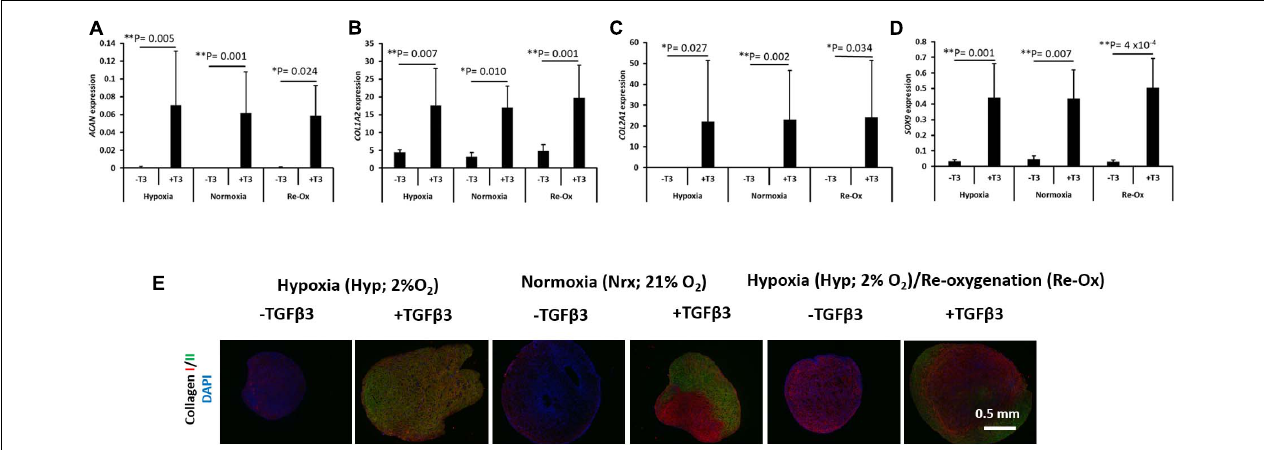
FIGURE 4 | Chondrogenic gene expression and immunofluorescence of types I and II collagen. Relative mRNA expression of (A) aggrecan ( ACAN ), (B) type I collagen ( COL1A2 ), (C) type II collagen ( COL2A1 ), and (D) SRY-Box transcription factor 9 ( SOX9 ) for seven donors with independent duplicates ( N = 7, n = 14 per experimental group). Gene expression was normalized to the geometric mean of three housekeeping genes ( YWHAZ , β -actin , and B2M ). Bar data are mean ± standard deviation. Statistical comparisons were based on Kruskal–Wallis test between without TGF β 3 (i.e., –T3) and with TGF β 3 (i.e., +T3) groups within an oxygen tension group. ∗ p -value < 0.05; ∗∗ p -value < 0.01. (E) Immunofluorescence (IF) for collagens I and II and DAPI for cell nuclei. All immunostained pellet sections were prepared at 5 µ